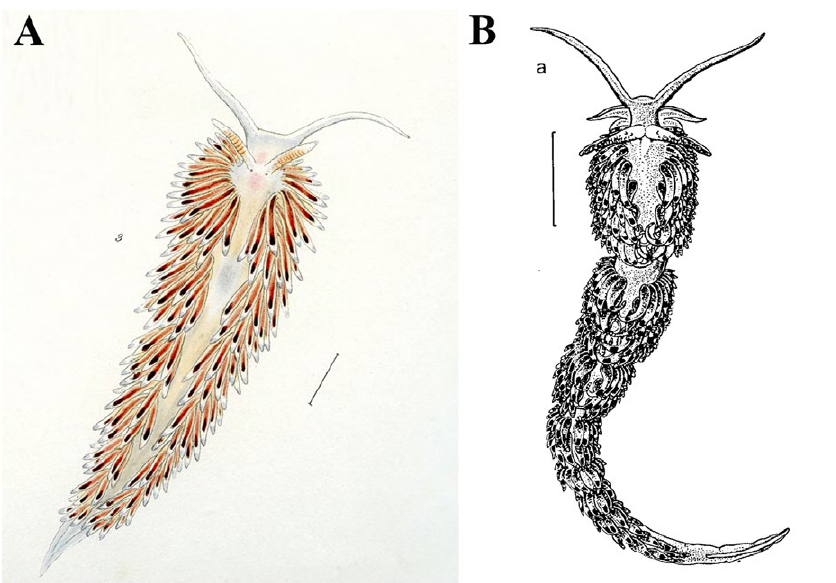
Fig. 1. – Caloria elegans morphological variability. A, original drawing from the redescription by Alder and Hancock (1845). B, drawing of the North Atlantic specimen (Picton,